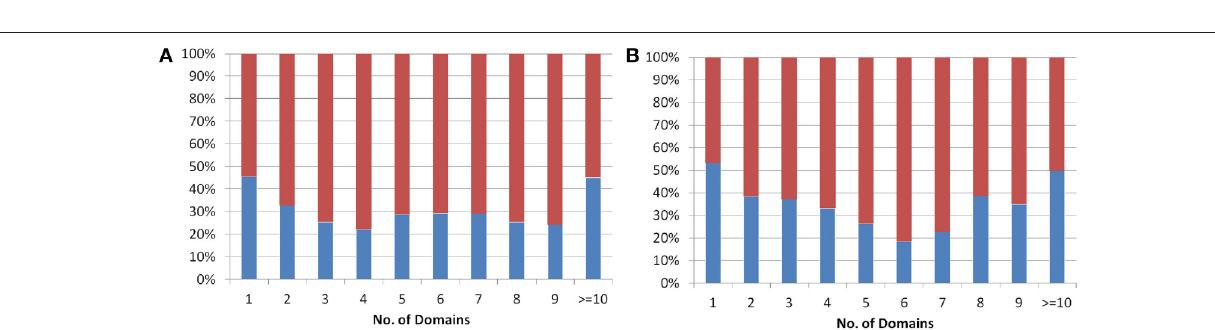
have statistically similar distribution ( Supplementary Figure 1